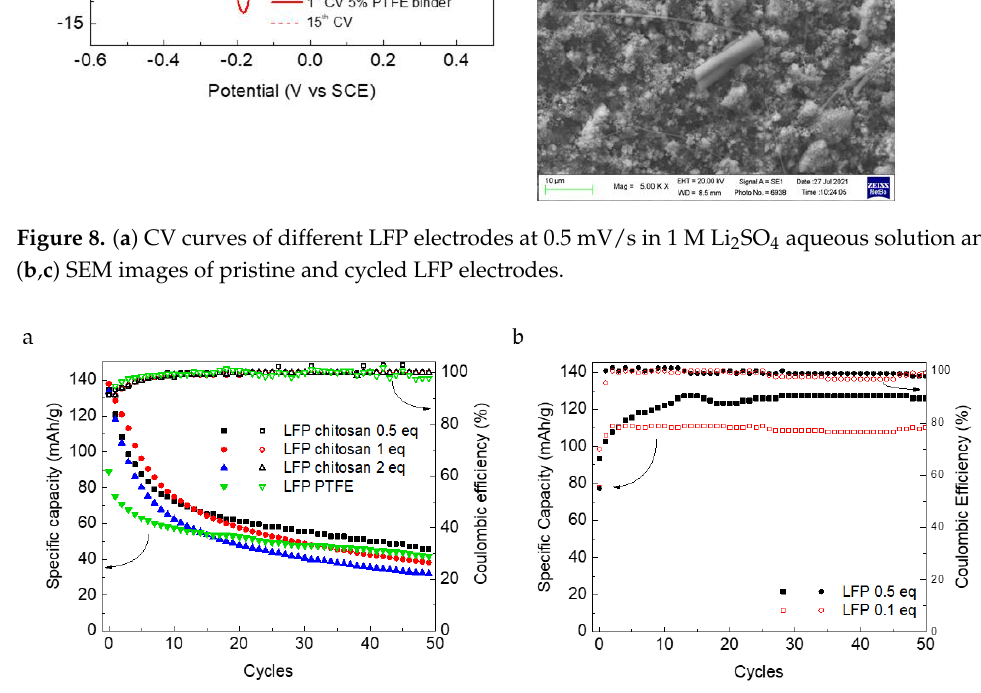
Figure 9. Specific capacity and coulombic efficiency value for LFP electrodes with different binders in LFP/FP cells: ( a ) chitosan crosslinked with 2, 1, and 0.5 equivalents of EDC and PTFE as a binder in 1 M Li 2 SO 4 aqueous solution and ( b ) chitosan crosslinked with 0.5 and 0.1 equivalents of EDC in organic electrolyte (LP 30).